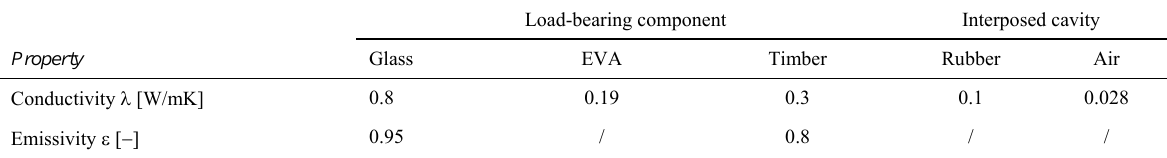
Table 1: Input thermal properties in use for FE modelling